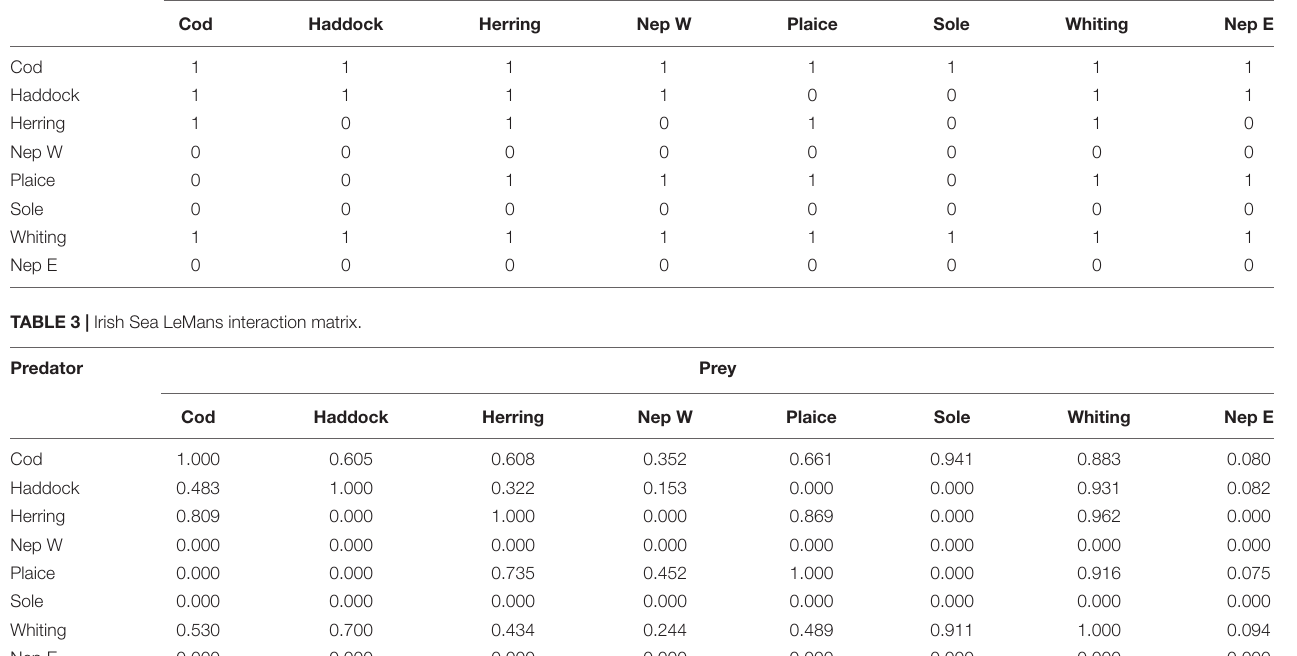
TABLE 2 | Irish Sea suitability matrix. Predator